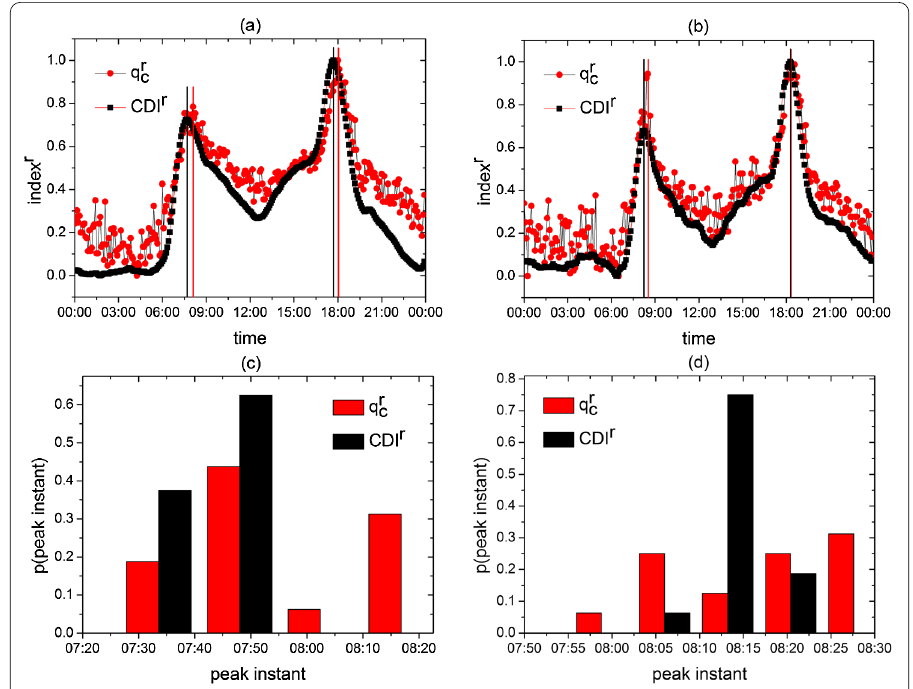
Figure 8 Different peak instants of different indices. (a) Different indices as a function of time in Beijing on Oct. 27th, Tuesday. (b) Different indices as a function of time in Shenzhen on Oct. 27th, Tuesday. Red lines mark the peaks of q r c and black lines mark the peaks of CDI r . (c) The distribution of morning peak instants of q r c and CDI r in workdays in Beijing. (d) The distribution of morning peak instants of q r c and CDI r in workdays in